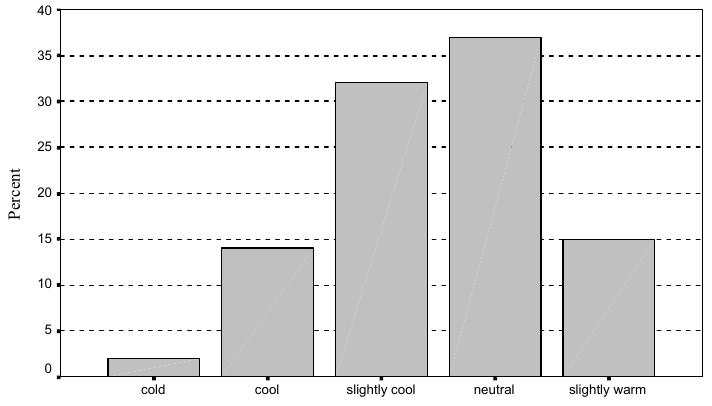
Figure 8. Southern Europe atrium expectation votes in the cool